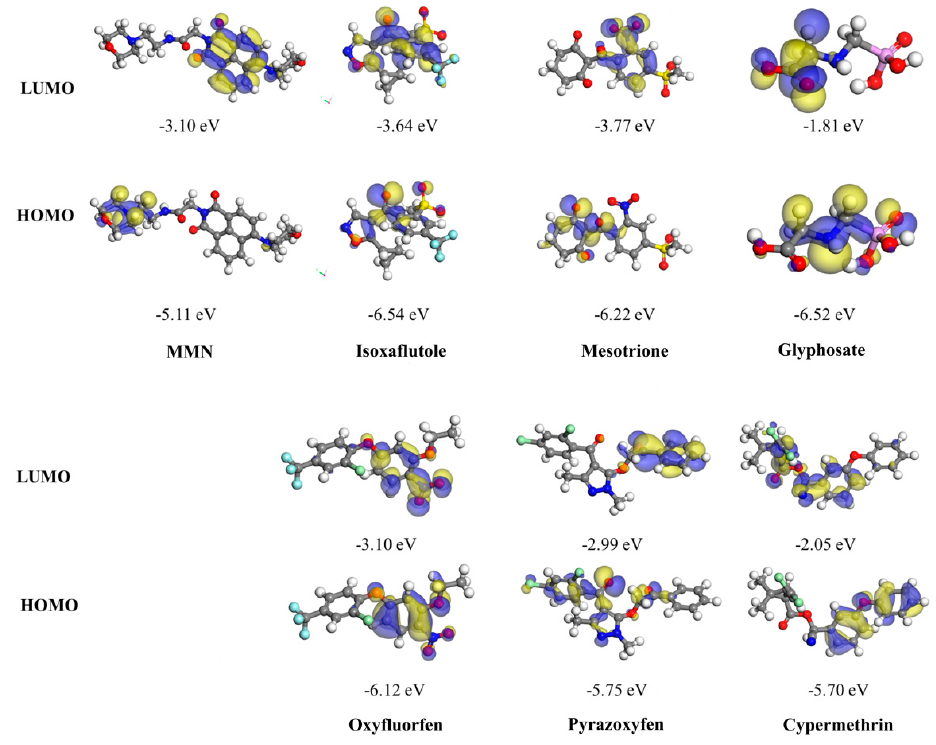
Figure 8. HOMO and LUMO molecular orbitals and relative energy levels of MMN and six pesti- cides.